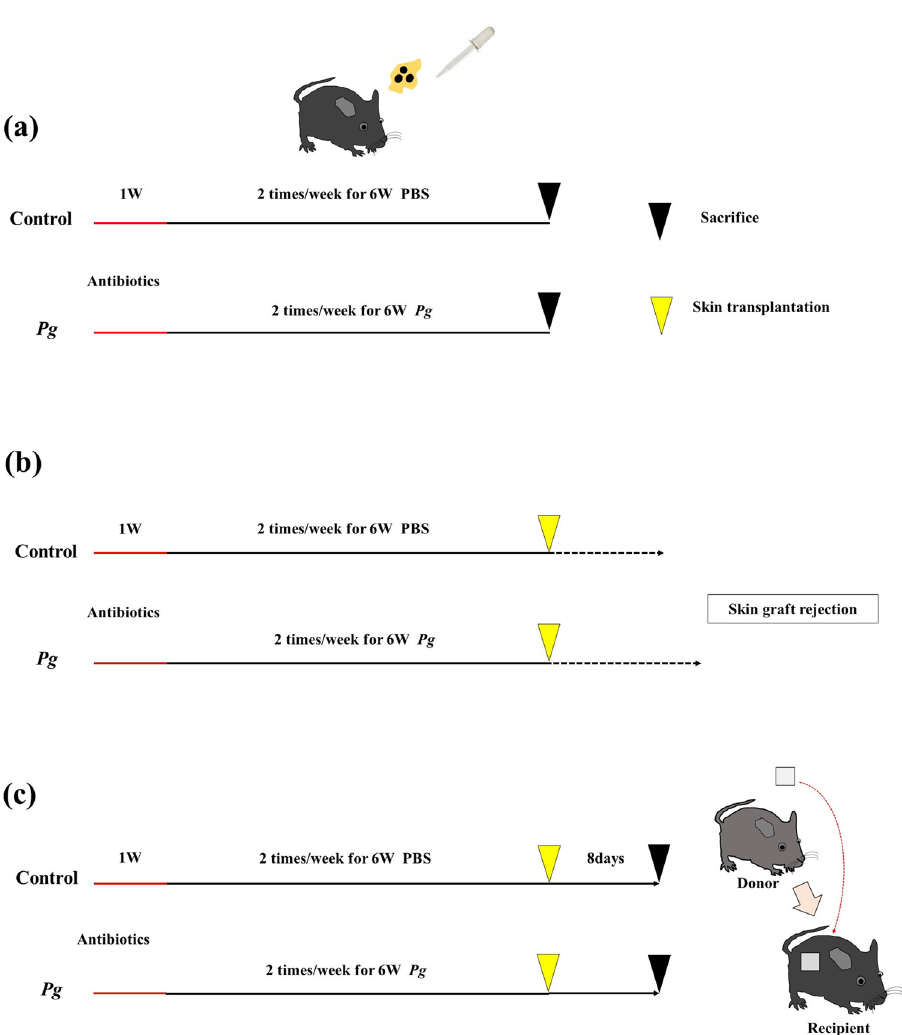
Figure 1. Study design. All mice used in this experiment were given antibiotics in their drinking water for one week. After that, mice in the Porphyromonas gingivalis group received Pg orally twice per week for 6 weeks, while mice in the control group received PBS orally twice per week for 6 weeks. ( a ) Both groups were sacrificed before transplantation. ( b ) Both groups received allogenic skin grafts and were monitored until skin graft rejection. ( c ) Both groups received allogenic skin grafts. On day 8 after skin grafting, the mice in both groups were